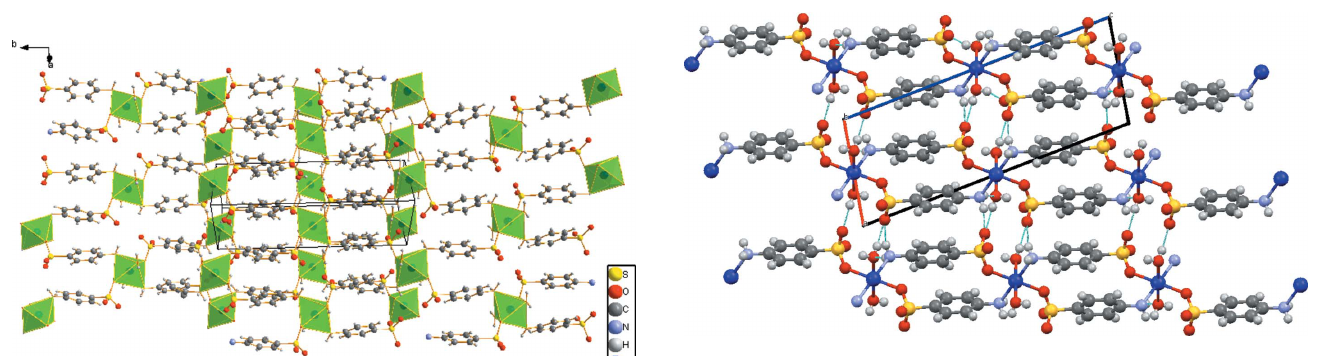
Figure 4 Three-dimensional supramolecular framework built from polymeric layers connected via hydrogen bonds.